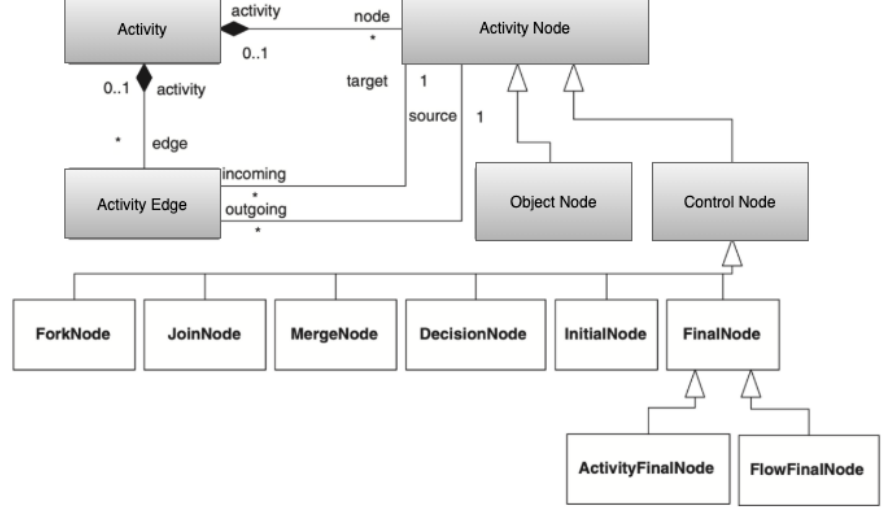
Figure 2. Activity diagram meta-model. The ’*’, wildcard, means 0...n cardinality.